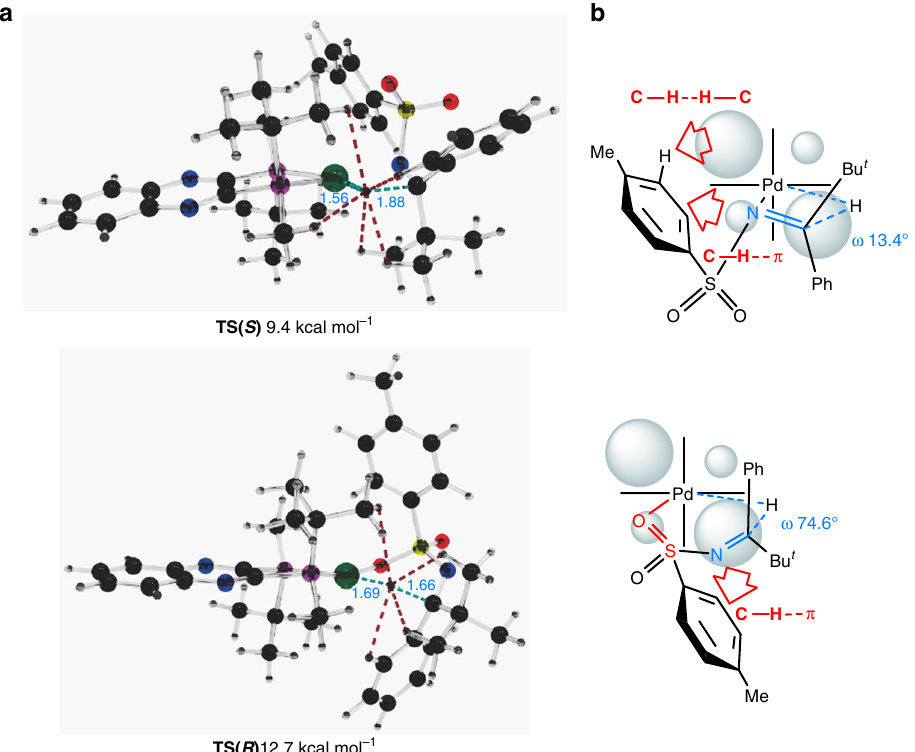
Fig. 6 The structures of TS( S ) and TS( R ) . Computed structures of the transition states for the hydride transfer. (WB97XD/SDD(Pd)/6-31G(d,p)(all others)/SMD(TFE)) (Arrows denote the interactions of two Data availability The authors declare that the data supporting the fi ndings of this study are available within the article and its Supplementary Information fi le. For the experimental procedures, data of NMR and HPLC analysis and Cartesian coordinates of the optimized structures, see Supplementary Methods and Charts in Supplementary Information fi le. The X-ray crystallographic coordinates for structures reported in this article have been deposited at the Cambridge Crystallographic Data Center ( 2a : CCDC 1585399, 7x : CCDC 1585398). These data could be obtained free of charge from The Cambridge Crystallographic Data Center via www.ccdc.cam.ac.uk/ data_request/cif.